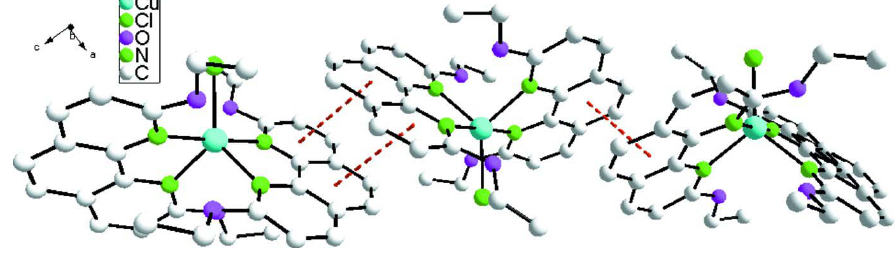
The molecular structure of the title complex, showing the atom-labelling scheme. Displacement ellipsoids are drawn at the 30% probability level and H atoms are not shown.